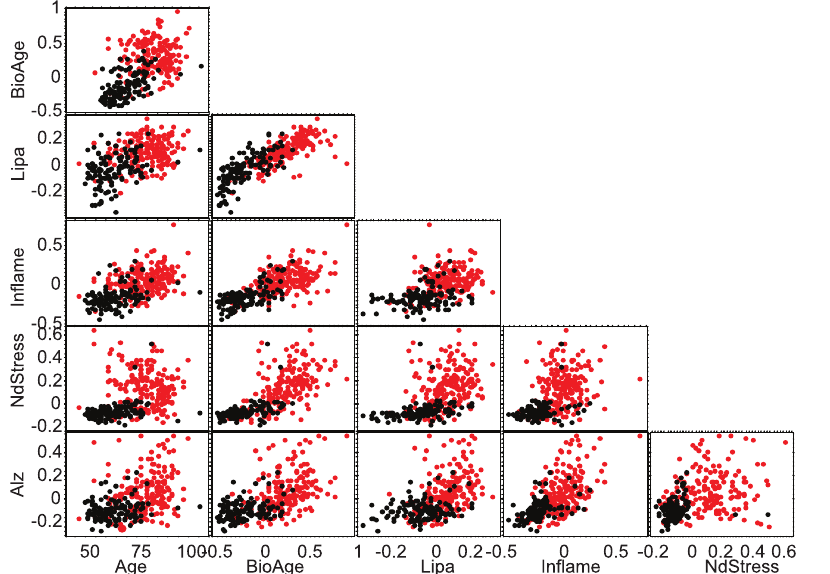
Figure 4. Plot matrix of mutual relationships between key aging and disease-specific biomarkers as well as chronological age. Each biomarker is represented by its score in each sample based on the average gene expression of contributing genes (see Methods). Non-demented PFC1 samples are shown by black dots. AD samples are shown by red dots. All pairwise relationships between the biomarkers and with chronological age are shown.